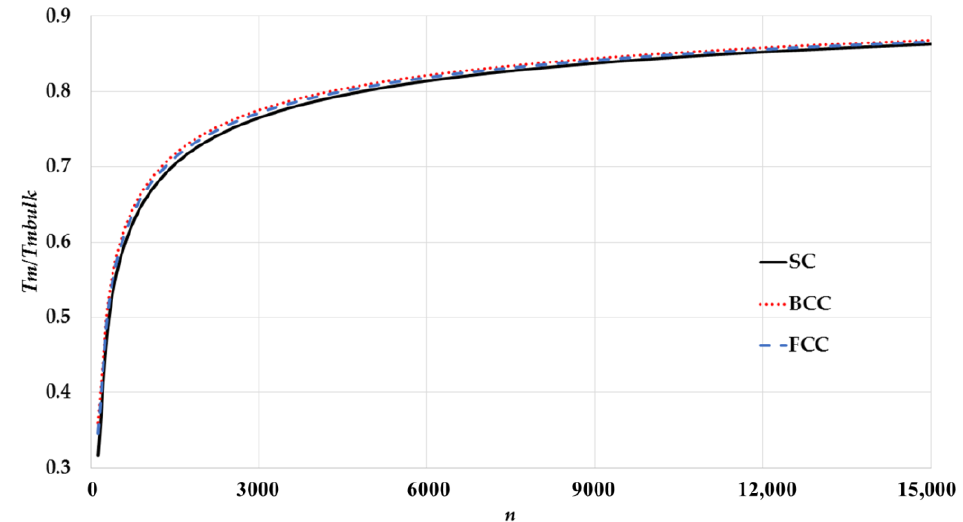
Figure 4. The variation of ratio T m / T mbulk as function of the number of atoms n of spherical nanoparticles in different cubic structures.